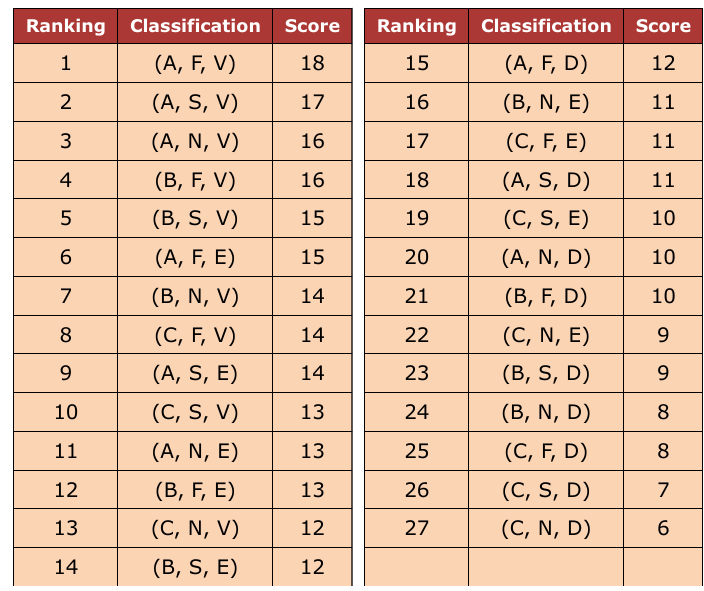
Table 6. Final classification ranks taking into account tie breaking